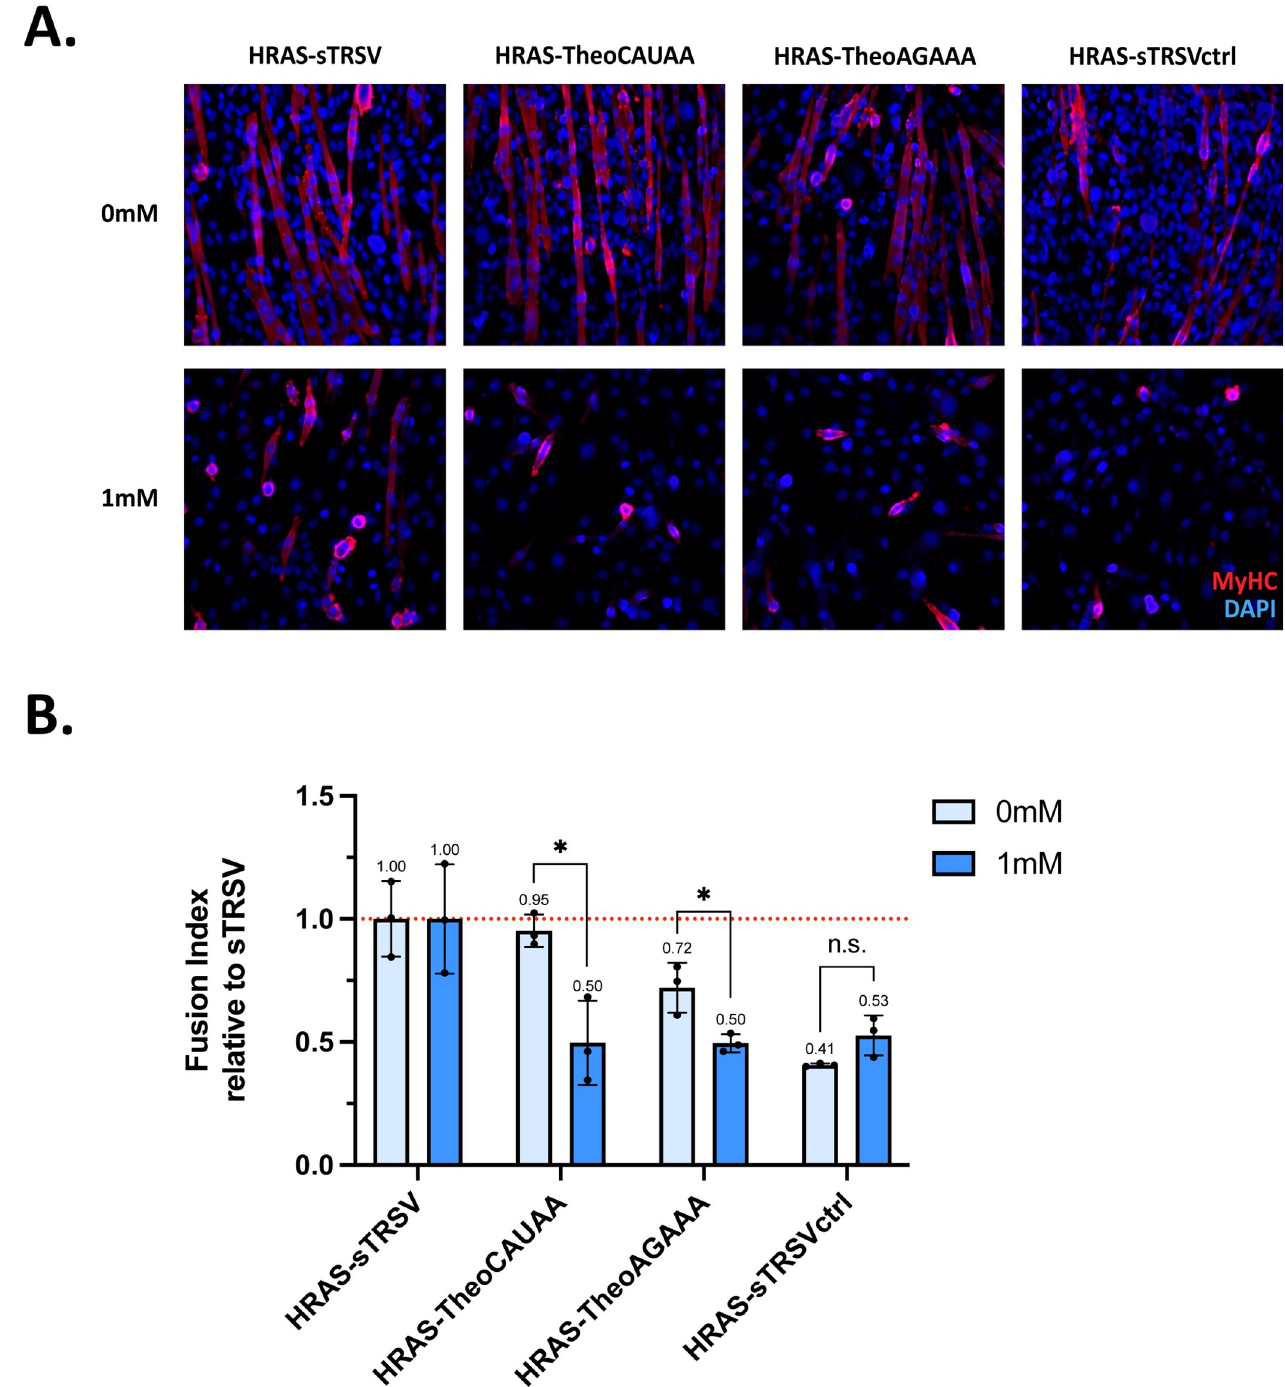
Fig 5. HRAS-based RNA controllers demonstrate theophylline-responsive inhibition of myoblast fusion. A. Representative immunofluorescence microscopy images at T5 of C2C12 cells transfected with the indicated HRAS constructs and cultured in medium with 0 or 1 mM theophylline. MyHC expression is shown in red while DAPI is shown in blue. B. Quantification of fusion index with HRAS-based RNA controller constructs. Fusion index values are means normalized to sTRSV; error bars indicate standard deviation of three biological replicates; asterisks indicate significance based on p-values from t- test, n.s. indicates not significant, � p < 0.01, �� p < 0.001, ��� p < 0.0001, ���� p < 0.00001.